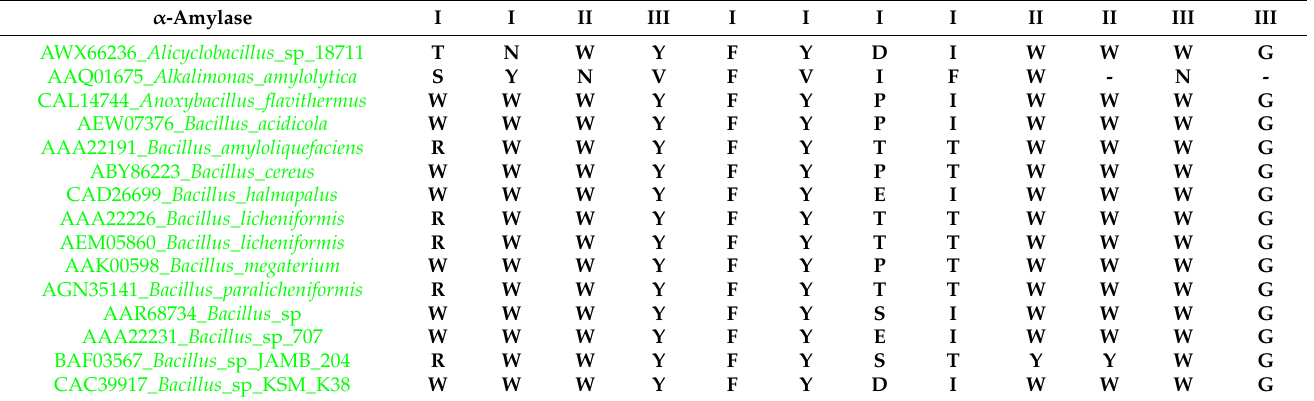
Table 3. Residues corresponding with SBSs of α -amylases from B. halmapalus , B. licheniformis and H. orenii a . α